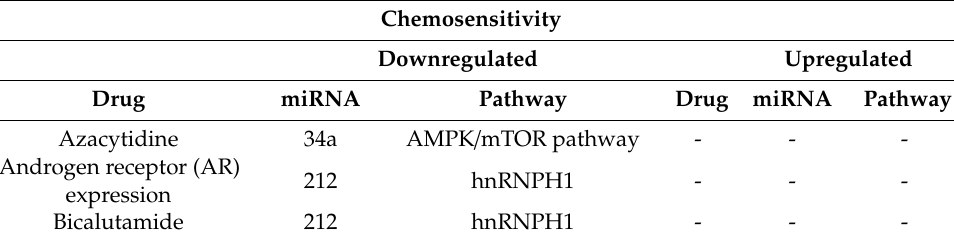
Table 3. Genetic pathways affecting chemosensitivity.